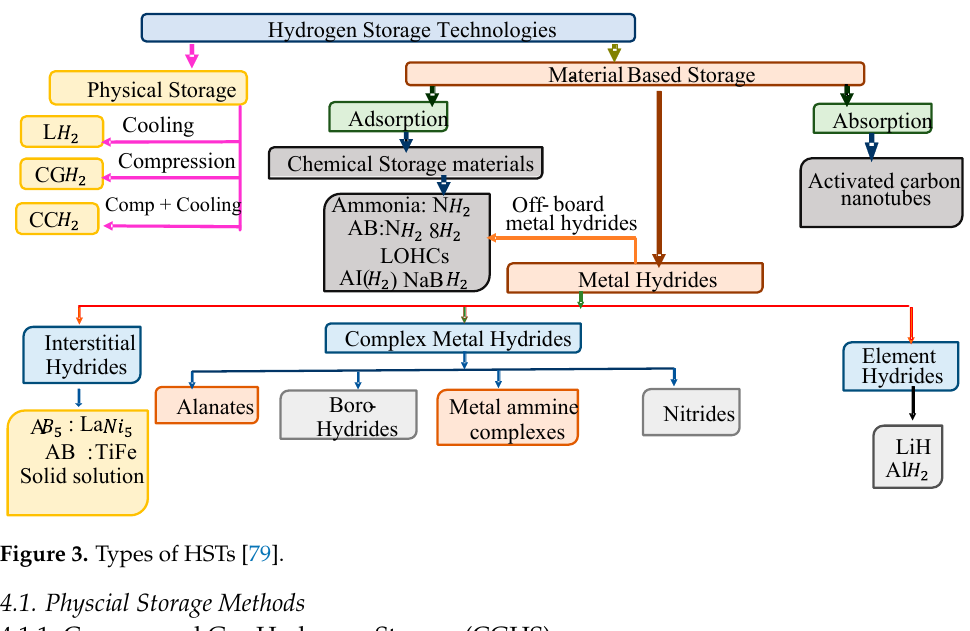
Figure 3. Types of HSTs